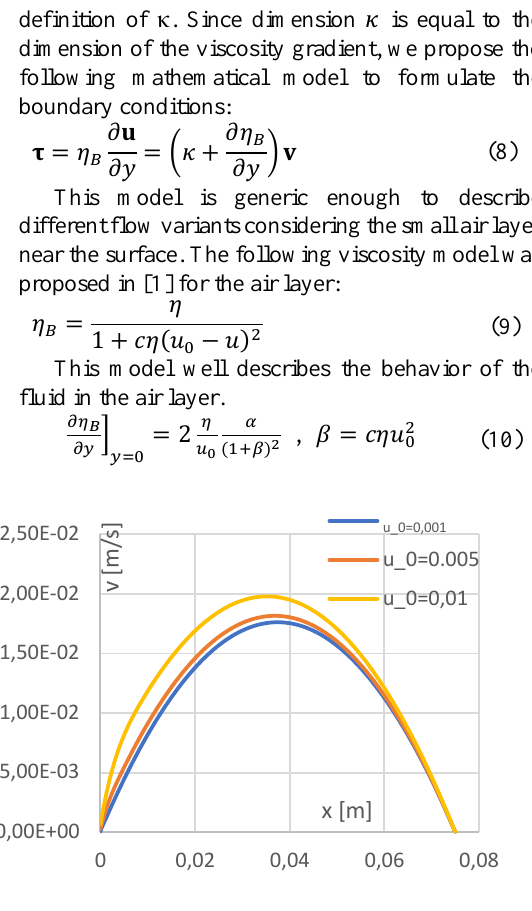
Fig. 1 Examples of the velocity profiles